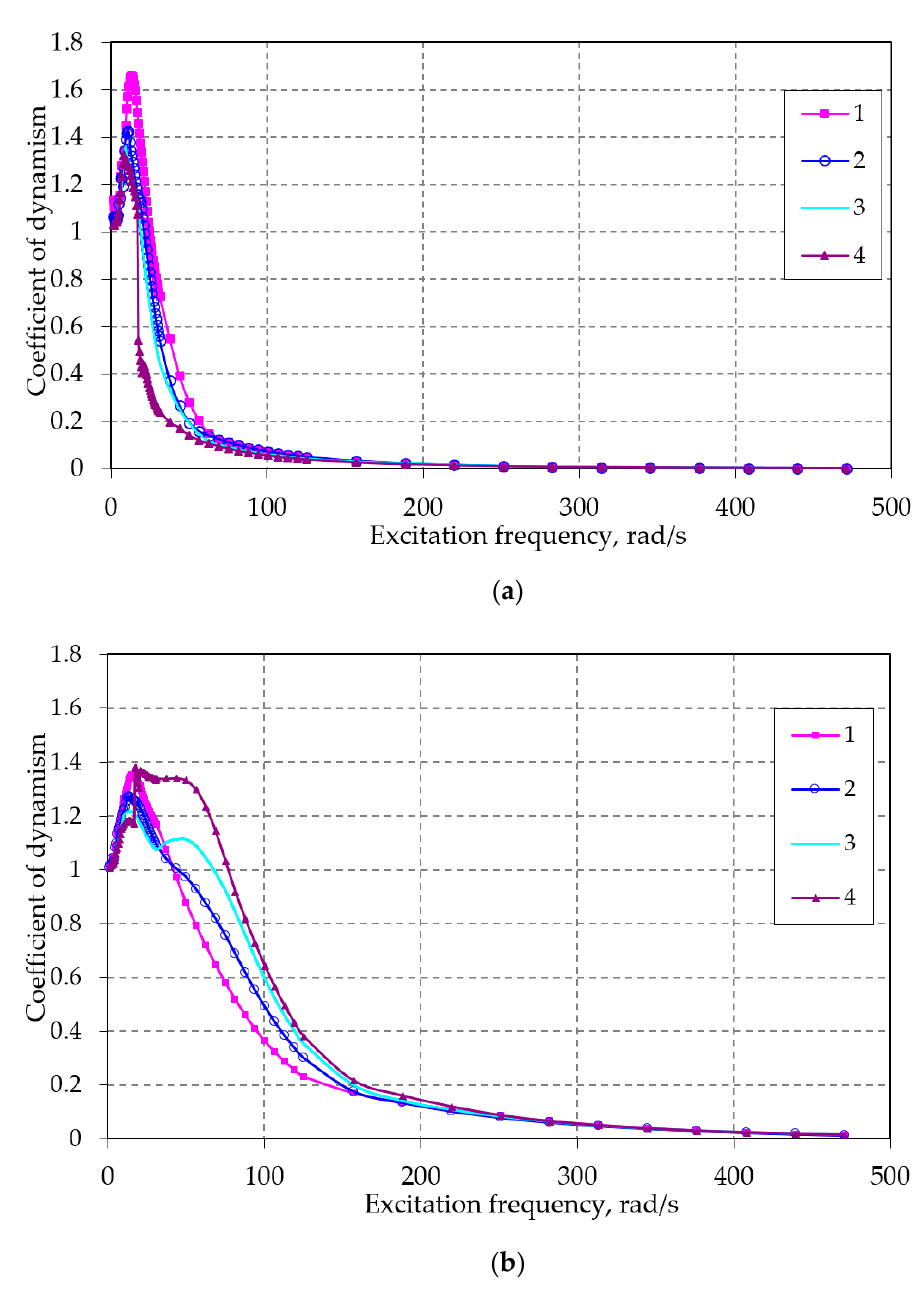
Figure 21. The influence of road unevenness on the sprung ( a ) and unsprung ( b ) mass displacements: 1—amplitude of irregularities 10.5 mm; 2—21 mm; 3—31.5 mm; and 4—42 mm.